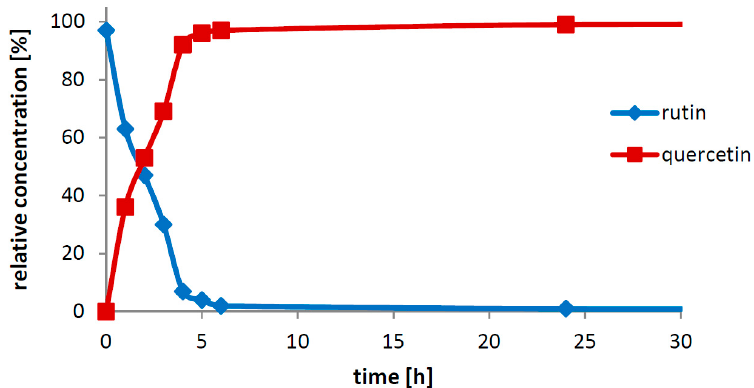
Figure 5. Bioconversion of rutin to quercetin under optimum conditions. Rutin 200 g/L; reaction volume 30 mL; 40 °C; pH 3.0; crude recombinant rutinosidase activity 0.8 U/mL.